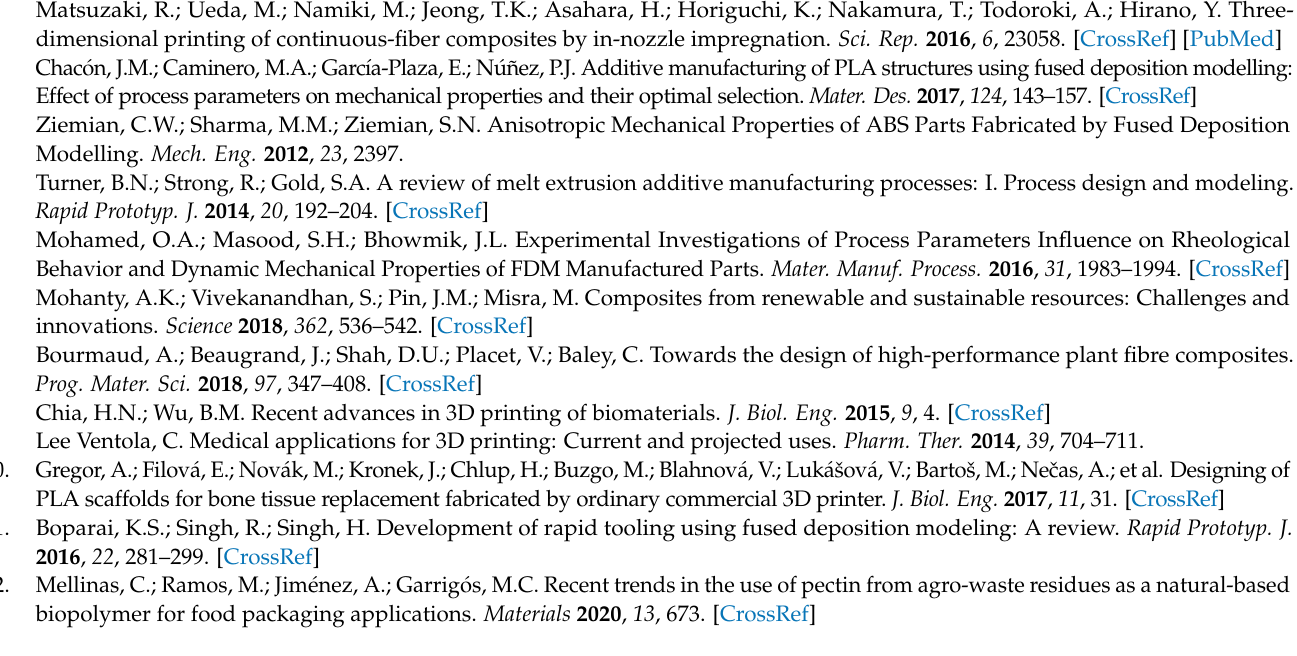
weighed. Table S1: Formulation of biocomposites; Table S2: Layer thickness in cm for